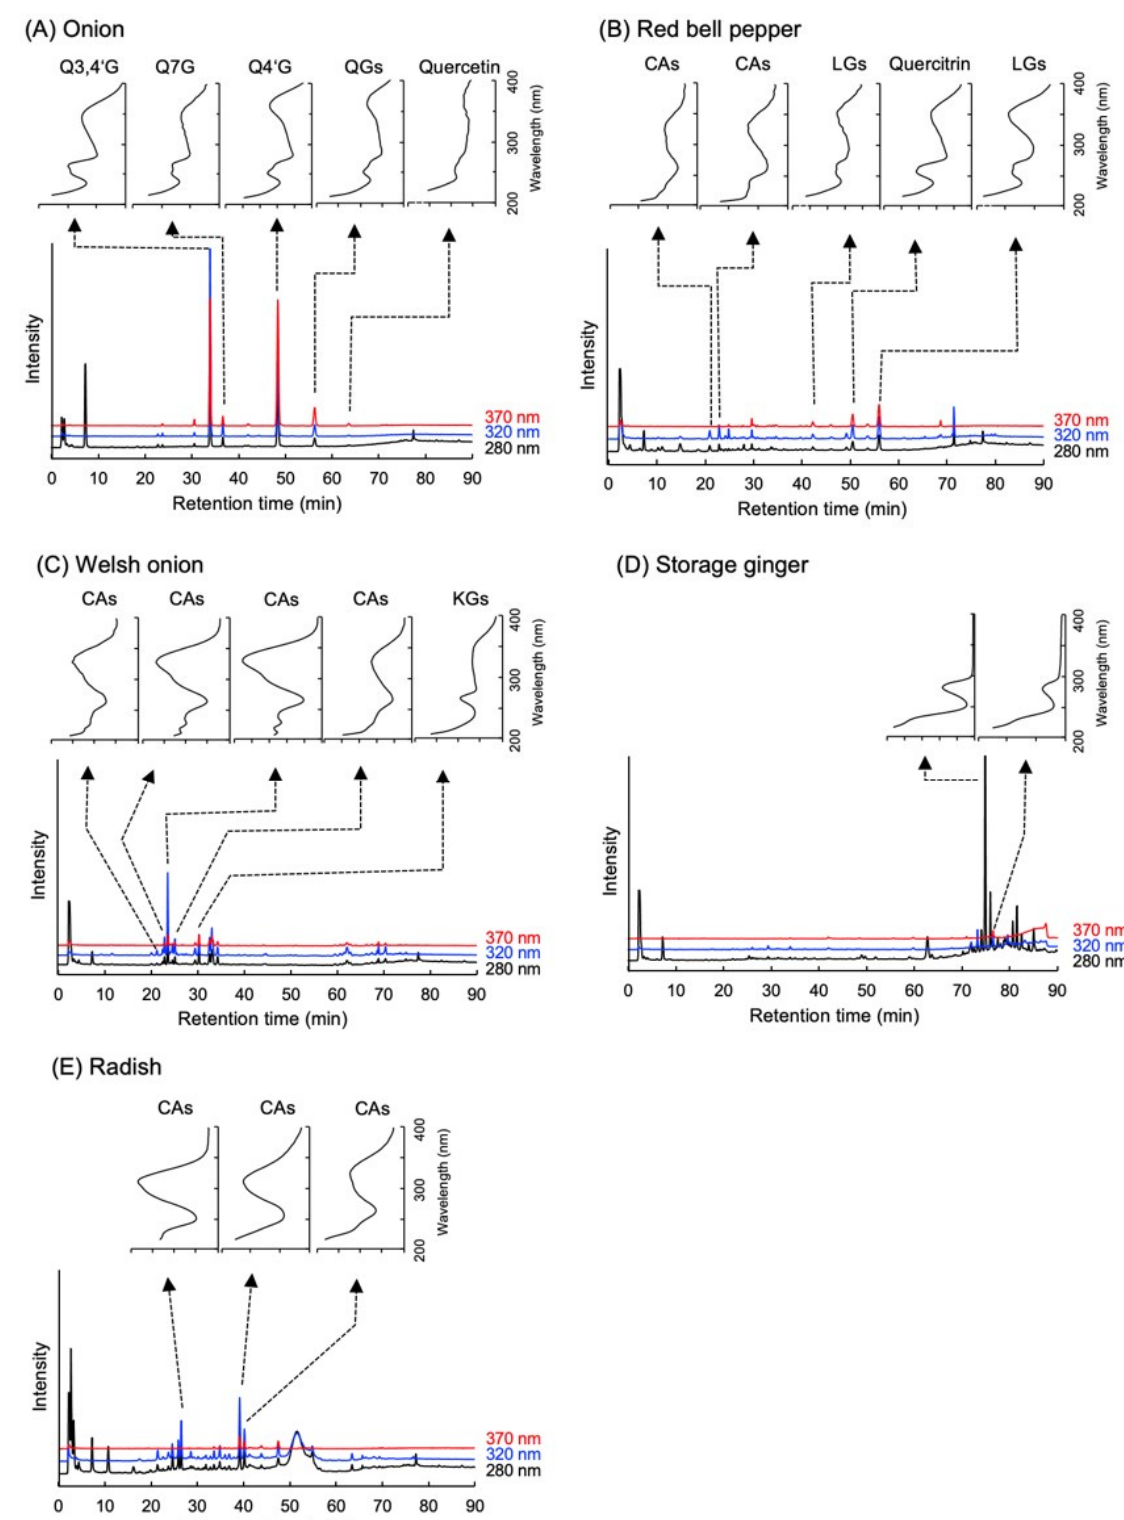
Figure 2. Typical HPLC chromatogram and UV-spectrum of ( A ) onion, ( B ) red bell pepper, ( C ) welsh onion, ( D ) storage ginger, ( E ) radish. Q3,4 ′ G, quercetin 3,4’-diglucosides; Q7G, quercetin-7-glucoside; Q4 ′ G, quercetin-4’-glucoside; QGs, quercetin glucosides; CAs, cinnamic acids; LGs, luteolin glucosides; KGs, kaempferol glucosides.